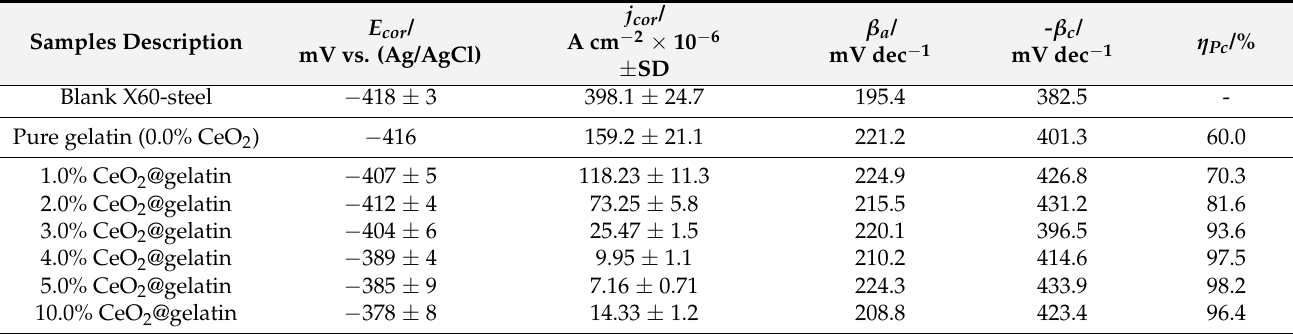
Table 1. Tafel parameters for blank and coated X60-steel in 15% HCl solution at 50 ◦